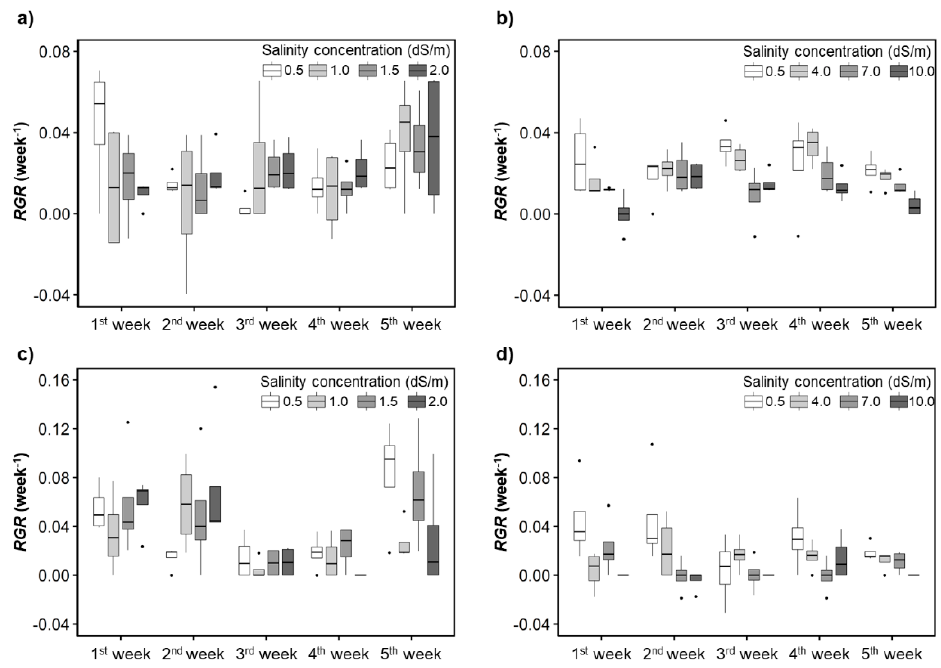
Figure 4. Responses of the relative growth rates (RGRs) to the irrigation water salinity levels. ( a , b ) H. rosa ‐ sinensis ; ( c , d ) M. splendens ; ( a , c ) first experiment; ( b , d ) second experiment.